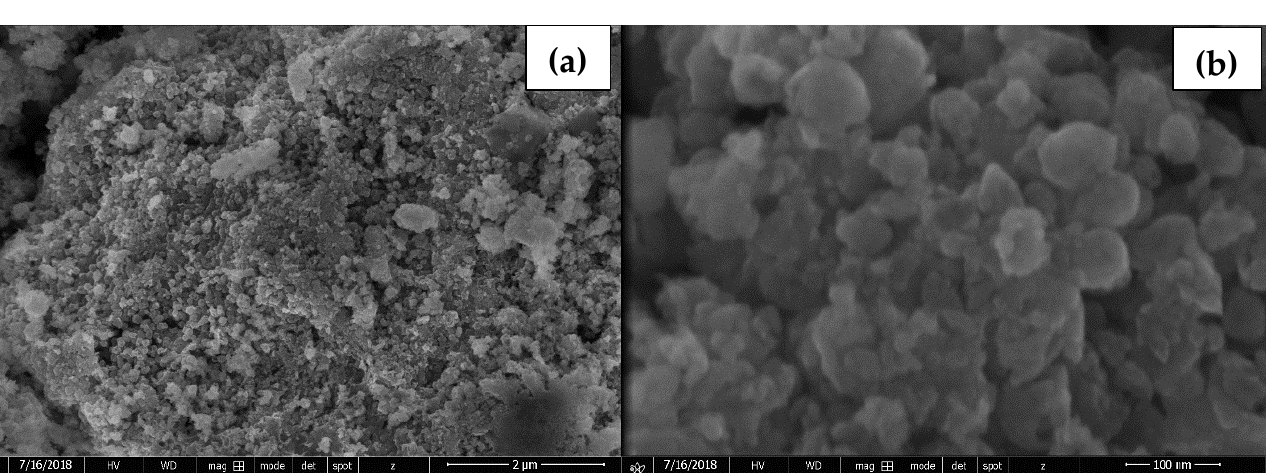
Figure 3. EDX spectrum of CuO NPs. 3.4. TGA Analysis The TG thermogram of CuO NPs shown in Figure 4, shows 9.99% weight loss oc- curred in two stages. The initial gradual weight loss occurred in the 40 – 350 °C tempera- ture range, which was caused by the loss of physically adsorbed water and highly volatile organic compounds. The second weight loss was seen at temperatures ranging from 360 to 750 °C, which was attributed to water evaporation associated with crystal lattice along with the breakdown of the coordinated bioorganic compounds, which is present in the sample due to the use of plant leaf extract in the synthesis of CuO NPs [28].